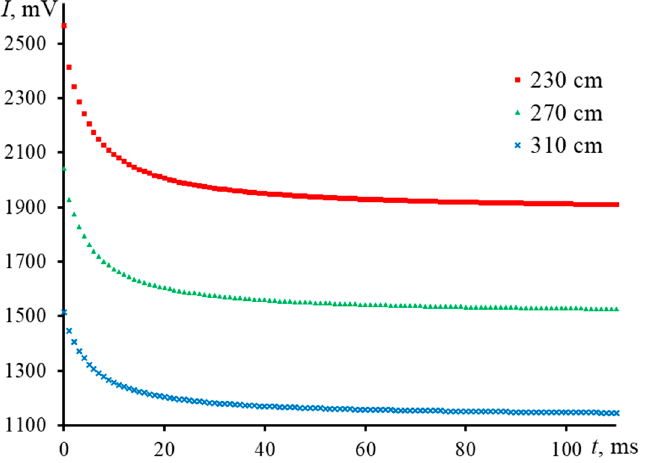
Figure 10. Influence of the sample-detector distance on the transient curves for an aqueous solution of ferroin (2.5 µ mol/L); middle-focused configuration ( ω e 0 = 42 µ m, Figure 2, Table 3). Table 4. Thermophysical parameters of a 2.5 µ mol/L aqueous solution of ferroin ( n = 5, P = 0.95). Z 2 , cm t c ,